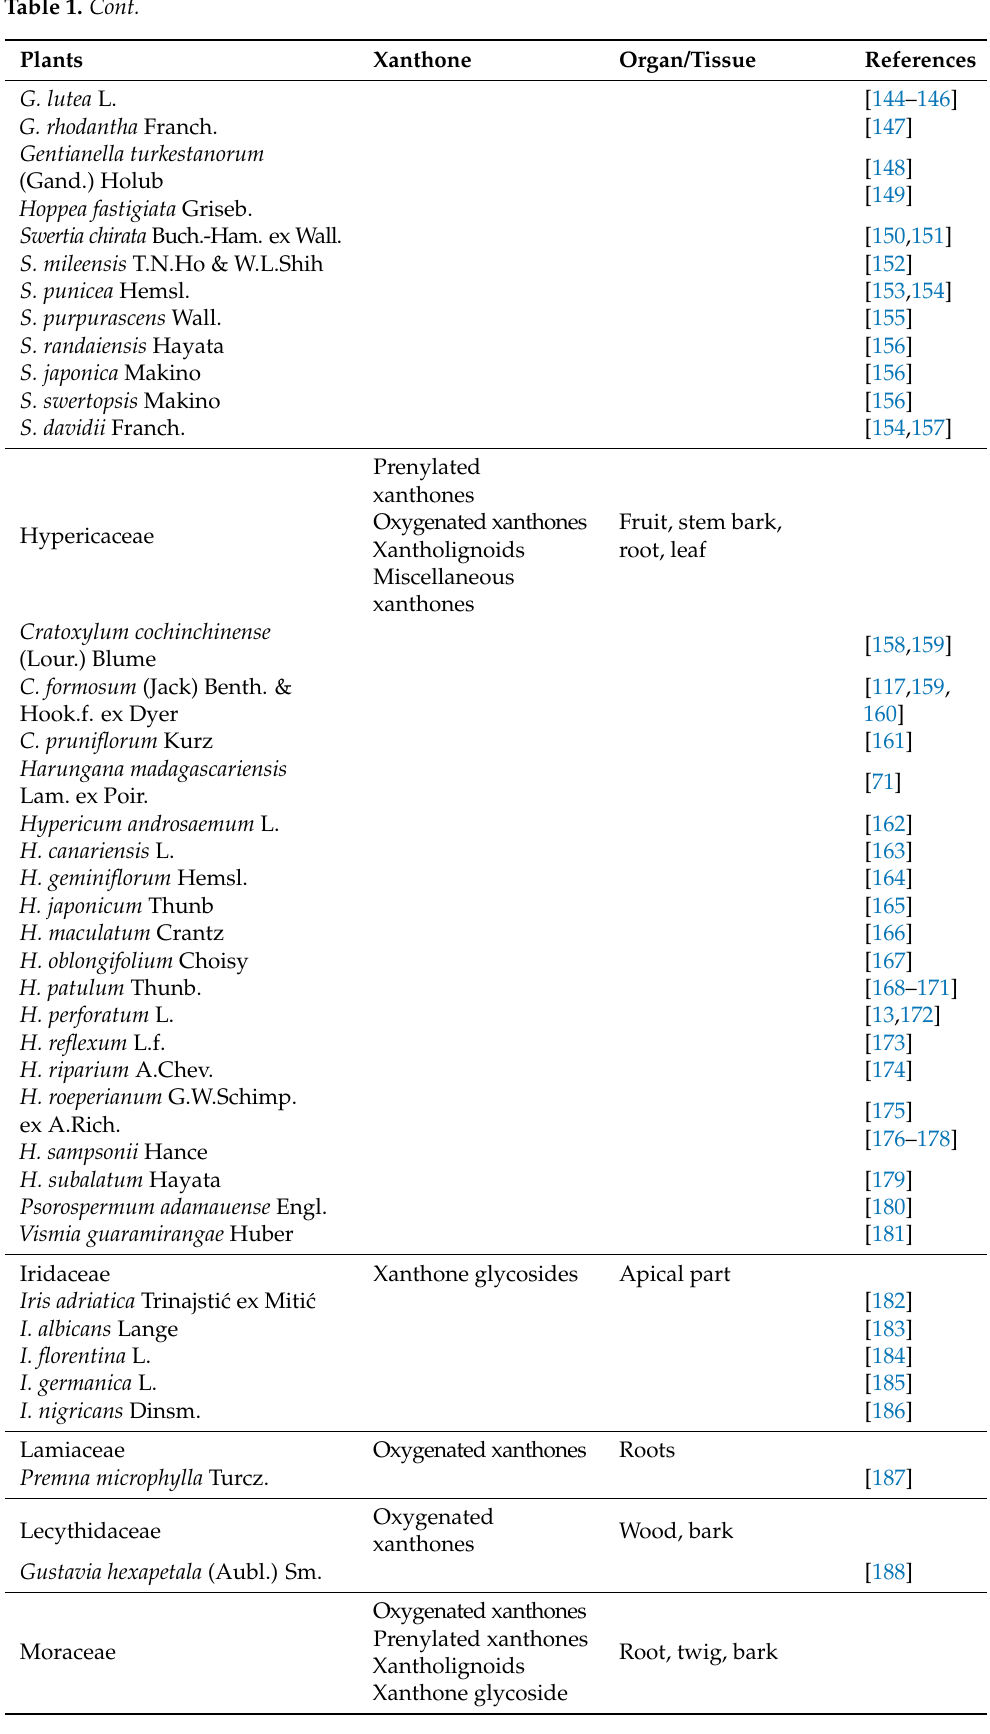
Table 1. Cont. Plants Xanthone Organ/Tissue